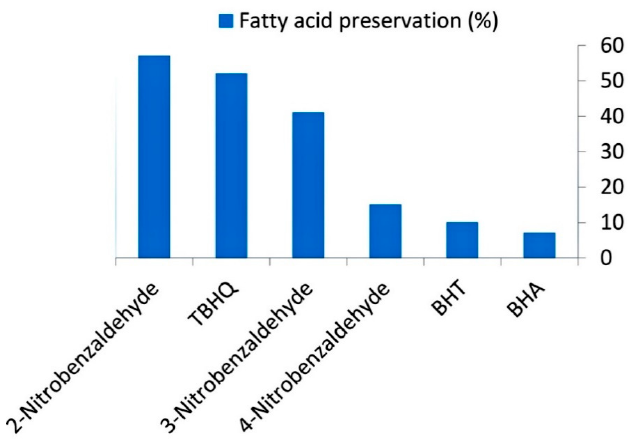
Figure 2. Diagram of fatty acid preservation (using oleic acid as a model substrate) in the presence of nitrobenzaldehyde isomers and well-known fatty acid antioxidants (BHA, BHT, and TBHQ).